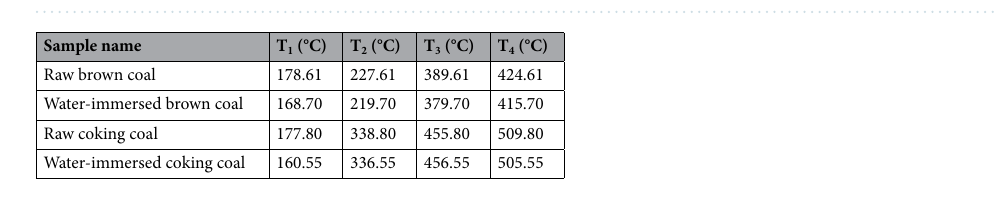
Table 3. Auto-ignition temperature characteristics of brown coal and coking coal before and after water- immersed.